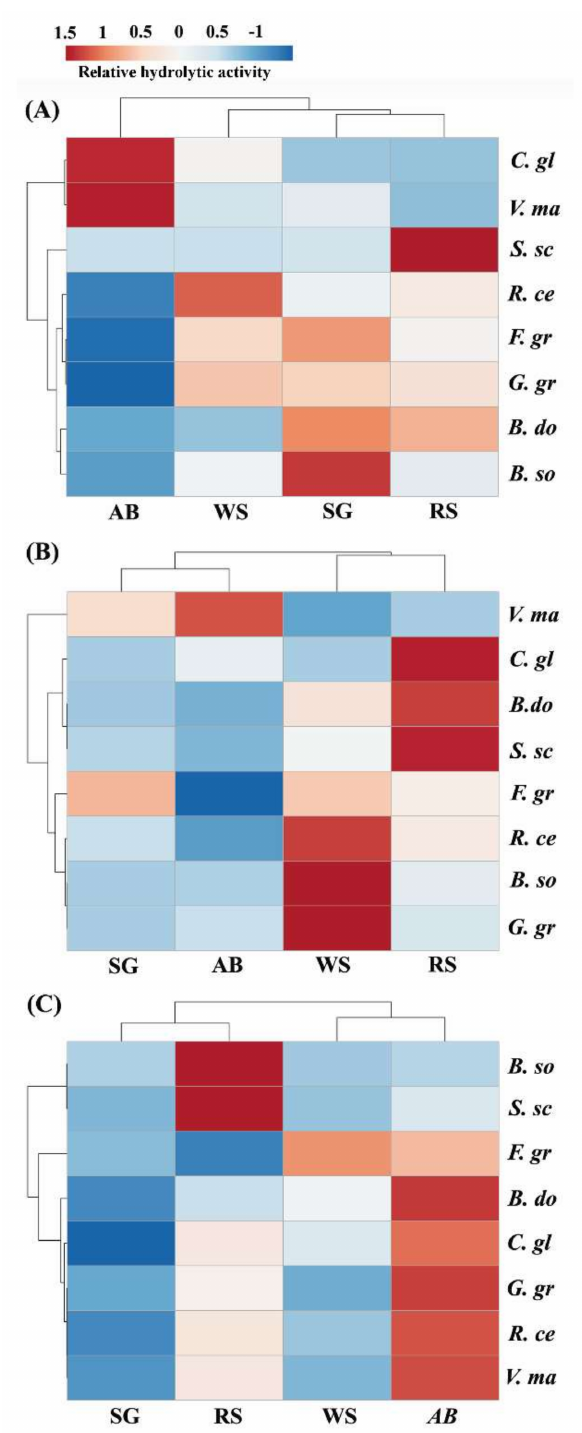
Figure 1. Hierarchical clustering of the pathogenic fungi tested. Heatmap showing the mean activities and clustering of 8 species of plant pathogenic fungi ( B. do , Botryosphaeria dothidea ; B. so , Bipolaris sorokiniana ; C. gl , Colletotrichum gloeosporioides ; F. gr , Fusarium graminearum ; G. gr , Gaeumannomyces graminis ; S. sc , Sclerotinia sclerotiorum ; V. ma , Valsa mali ), when assayed for hydrolysis of 4 crop residues (AB, apple tree branch; WS, wheat straw; SG, switchgrass straw; RS, rapeseed straw) untreated ( A ) or pretreated by hemicellulases ( B ) or PAA ( C ). The activity assay was performed as described in a previous study